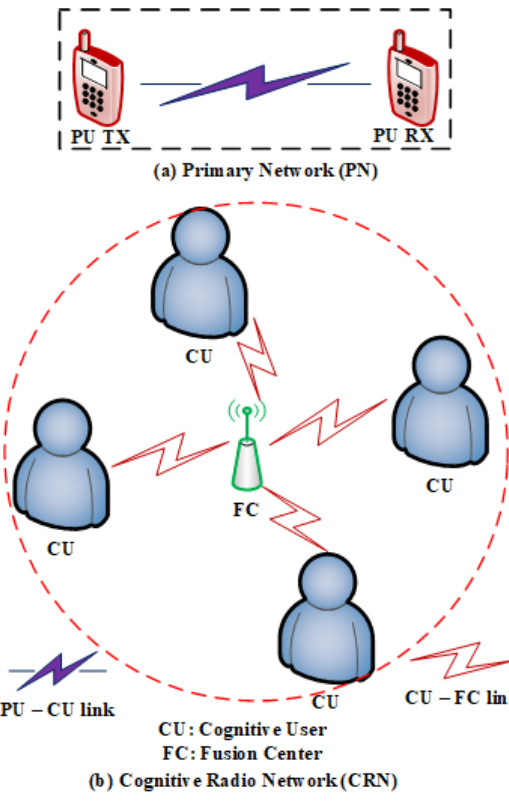
Figure 1. The proposed system